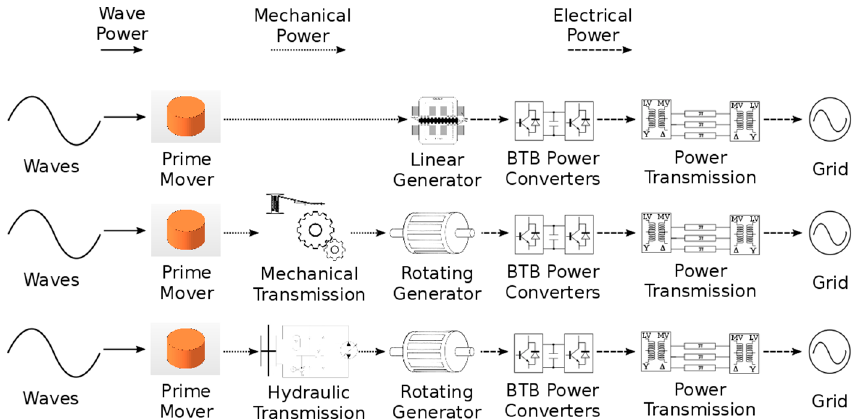
Figure 1. The conversion of power at each stage for different concepts of PTO systems in point absorber WECs.